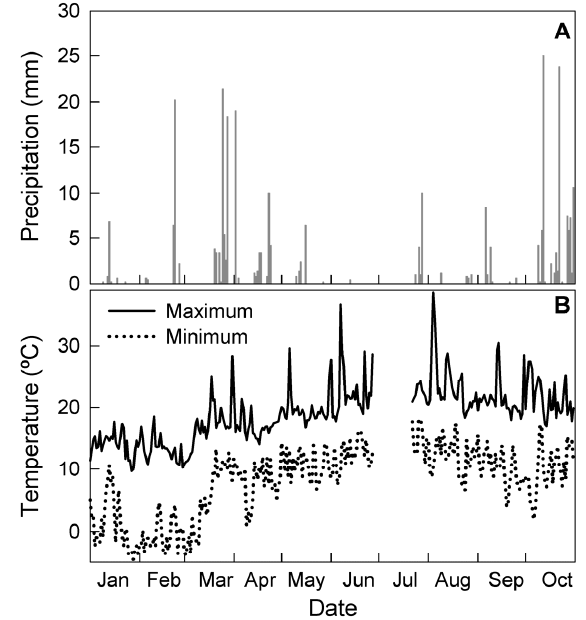
Fig. 2. January through October 2005 (A) precipitation and (B) tem- perature for Osso da Baleia, Portugal. Data from 28 June to 21 July 2005 are missing due to data logger failure.